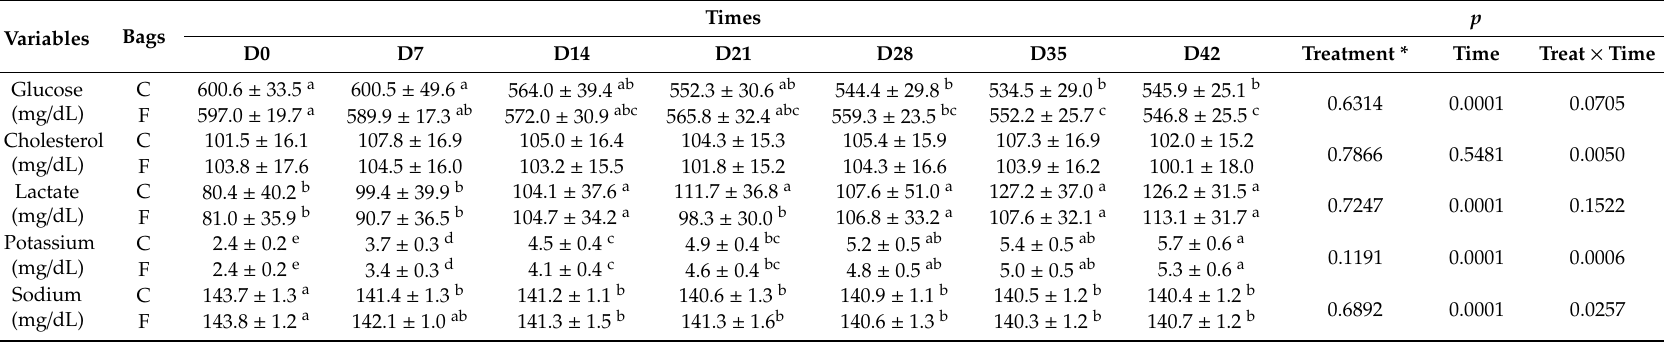
Table 3. Mean values and standard deviations of the biochemical variables of the cattle whole blood stored in CPD / SAG-M (C) and CPD / SAG-M with Filter (F) bags for 42